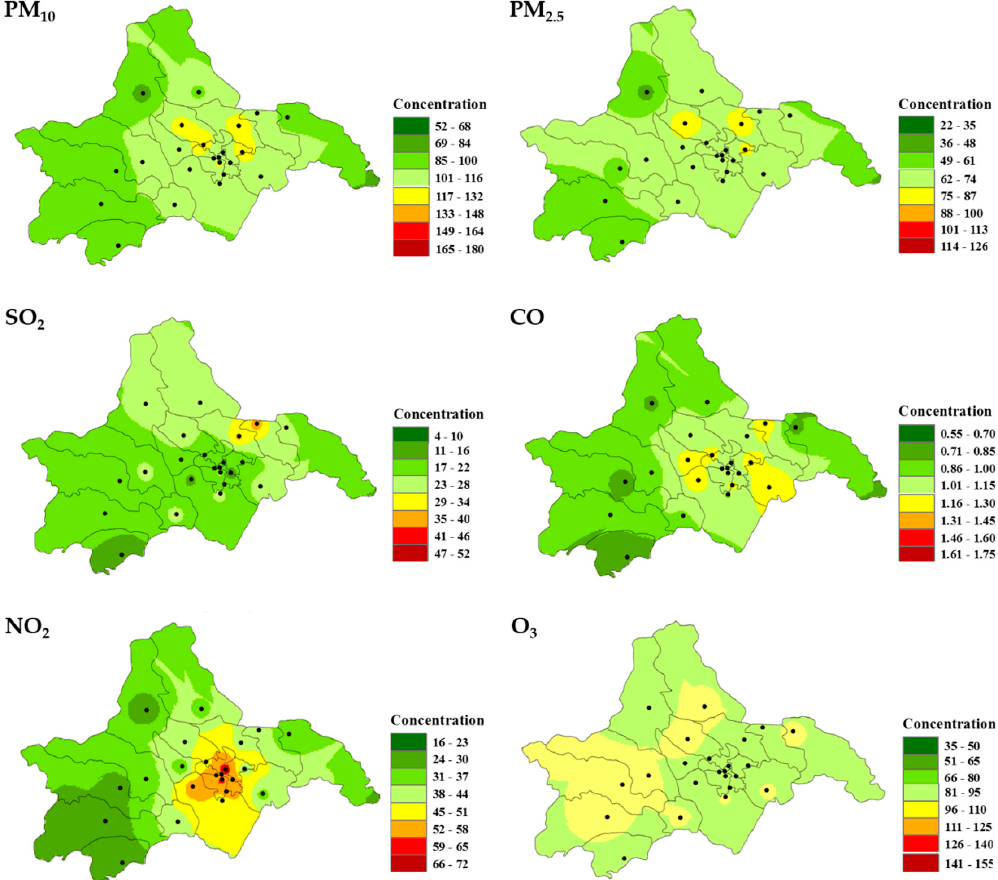
Figure 3. Spatial distributions of mean PM 10 , PM 2.5 , SO 2 , CO, NO 2 and O 3 concentrations during 2014 and 2016. The units for PM 10 , PM 2.5 , SO 2 , NO 2 , and O 3 are µ g m − 3 , whereas that for CO is mg m − 3 and 2016. The units for PM 10 , PM 2.5 , SO 2 , NO 2 , and O 3 are µg m –3 , whereas that for CO is mg m –3 .